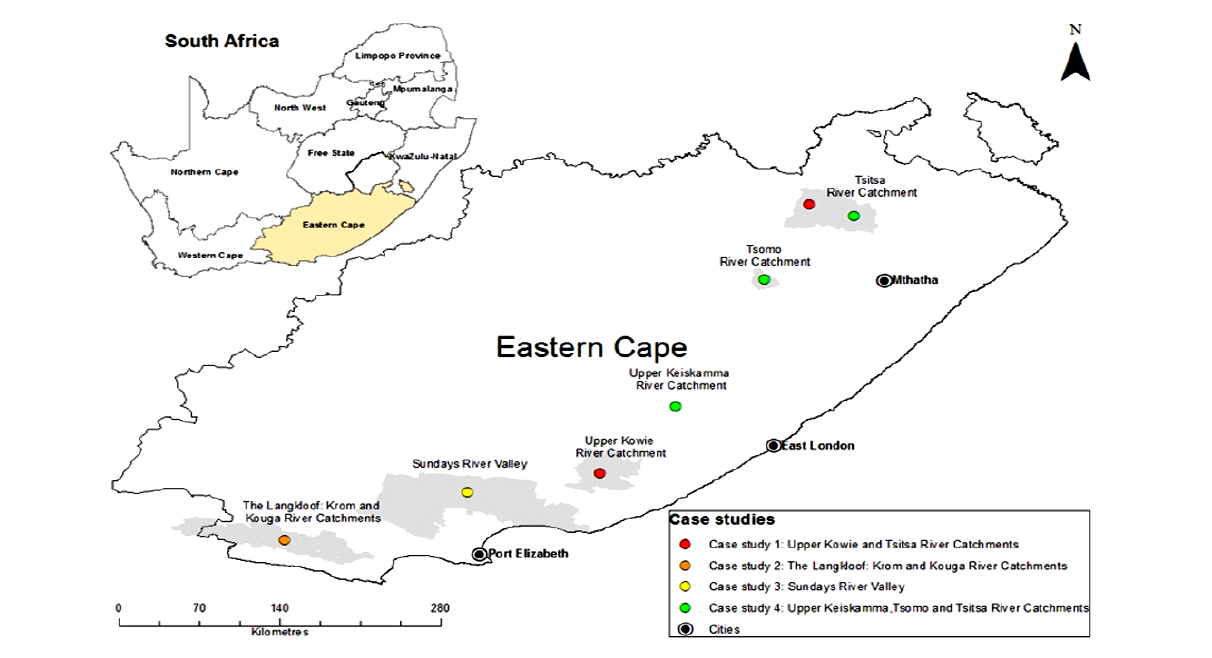
Fig. 1 . Case studies discussed in this paper. The map shows the location of each of the places discussed in each case